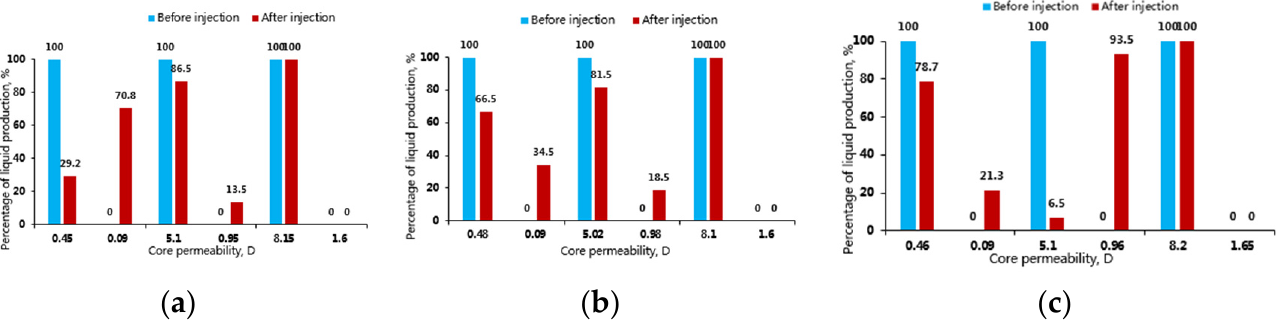
Figure 9. Percentage of liquid production of sand-packed cores in total liquid production before and after injection of the three systems. ( a ) Polymer; ( b ) Aluminum gel; ( c ) Phenolic gel.